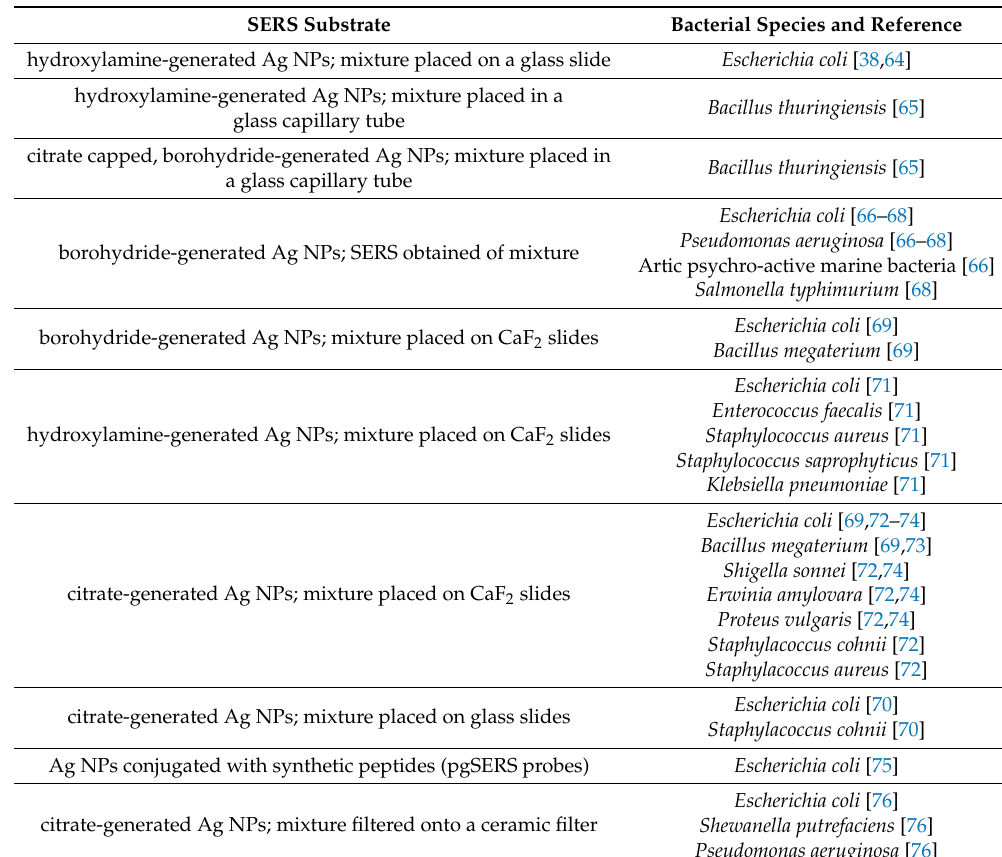
Table 3. Summary of bacteria detected by mixing colloids with bacteria that were discussed in this